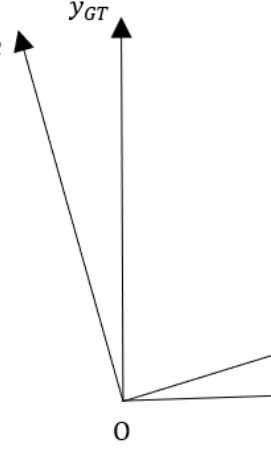
Figure 2. Change of reference system. x GT : physical longitudinal displacement; x VR : virtual longitu- dinal displacement; y GT : physical lateral displacement; y VR : lateral virtual displacement.